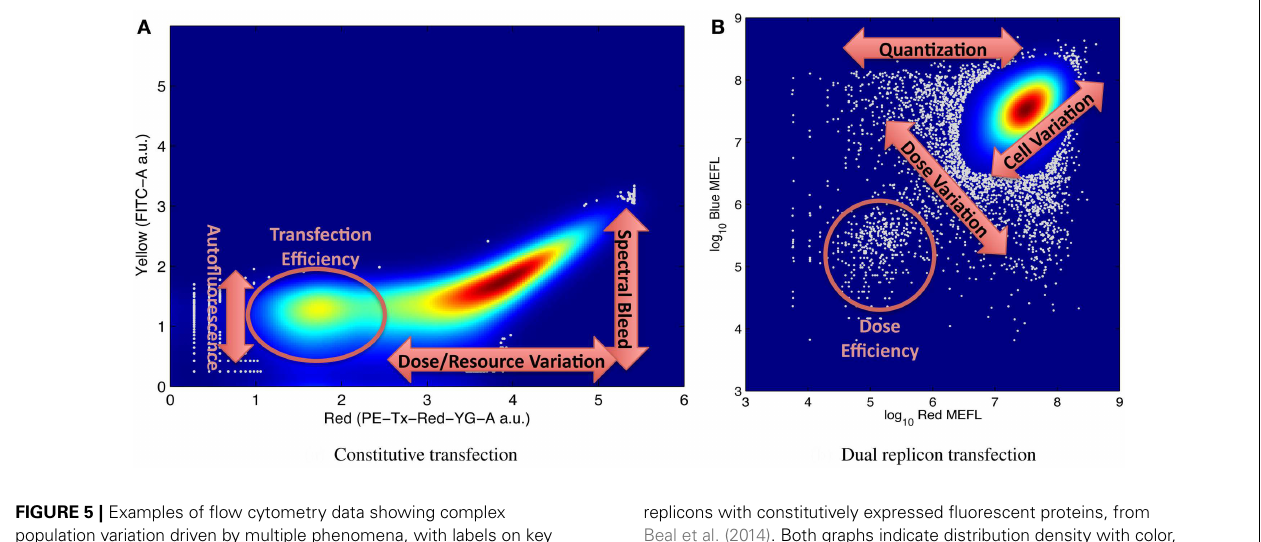
FIGURE 5 | Examples of flow cytometry data showing complex population variation driven by multiple phenomena, with labels on key portions of the distribution used for estimating model parameters: (A) transient transfection of a single constitutively expressed fluorescent protein, from Adler et al. (2014), and (B) cotransfection of two